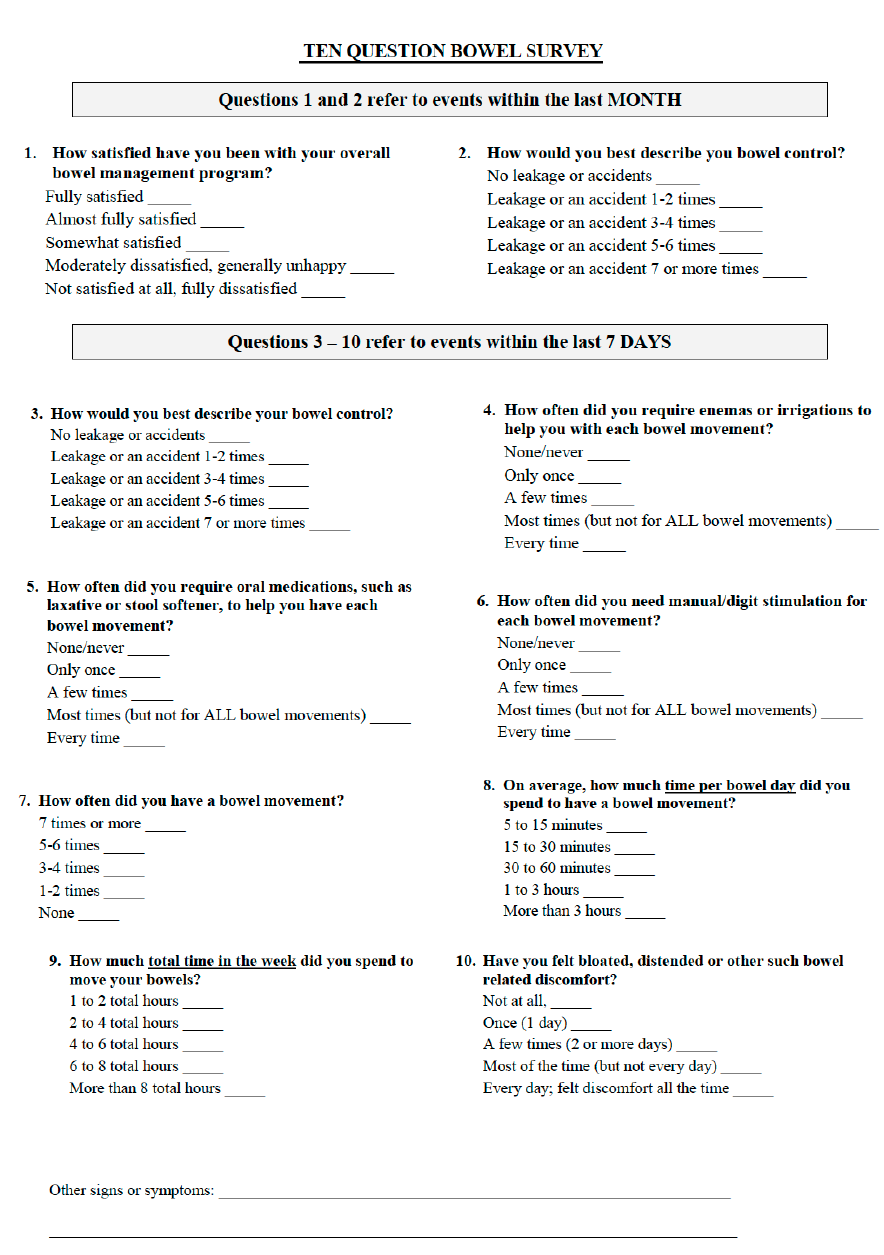
Figure A1. Ten Question Bowel Function Survey (10Q).